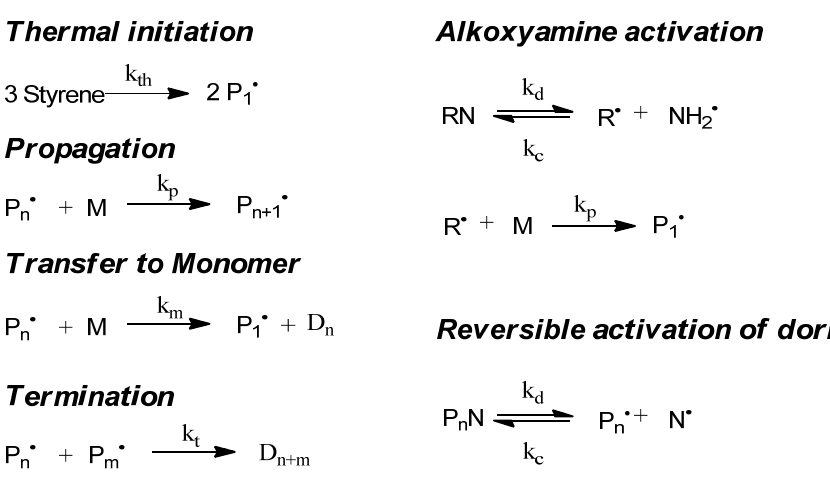
Figure 2. Kinetic model of nitroxide mediated radical polymerization (NMP).